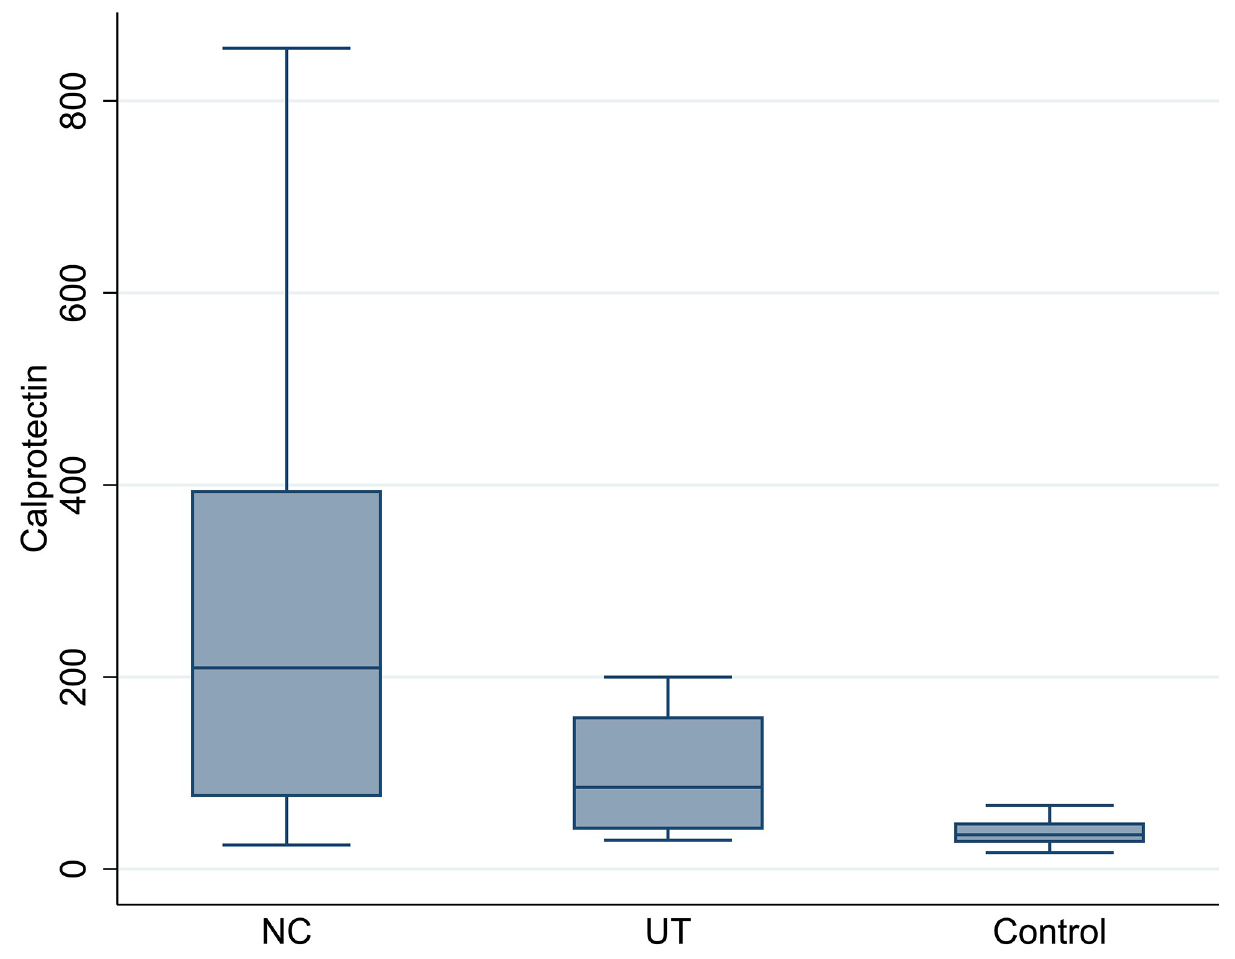
Fig 1. The comparison of mean of CP among three study